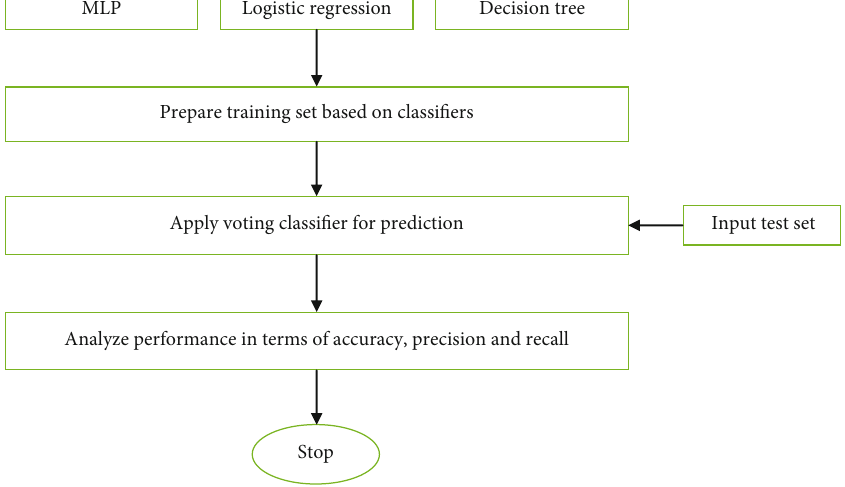
Figure 4: Ensemble 3 classi fi er